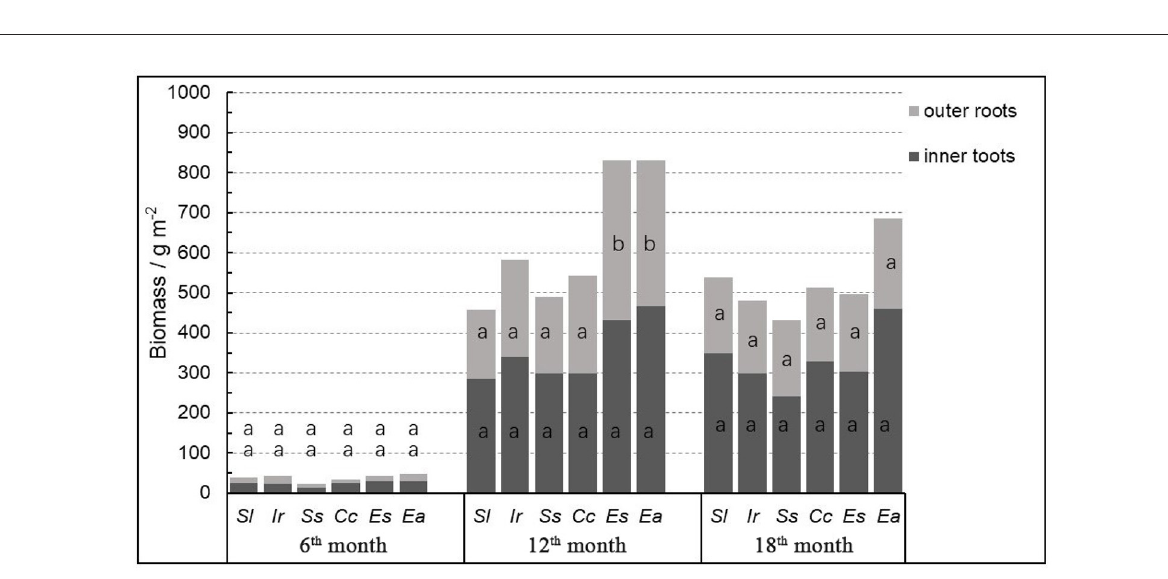
FIGURE5 Horizontal development of fine root biomass (g m − 2 ) of all the six tree species from the 6 to 18th month since plantation. The abbreviations of Sl , Ir , Ss , Cc , Es , and Ea were short for Sterculia lanceolata , Ilex rotunda , Schima superba , Cinnamomum camphora , Elaeocarpus sylvestris , and Elaeocarpus apiculatus . The dark gray and light gray bars represent the inner roots (located at 15cm to tree trunks) and outer roots (located at 30cm to tree trunks), respectively. The letters “a” and “b” indicate significant differences ( P < 0.05) between fine root biomass of different tree species in the same